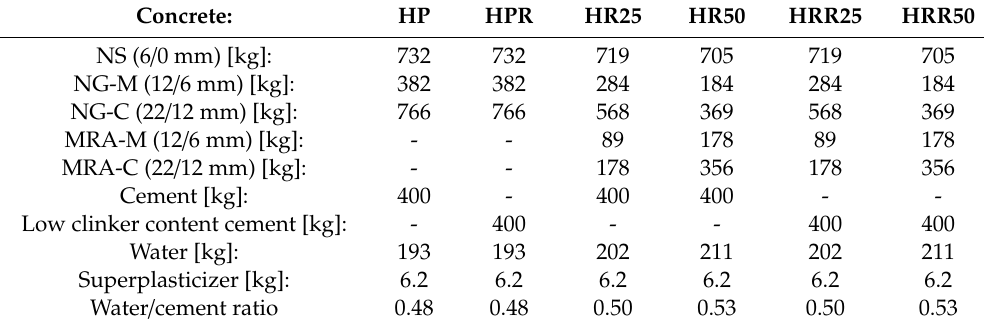
Table 2. Concrete mix proportions (by m 3